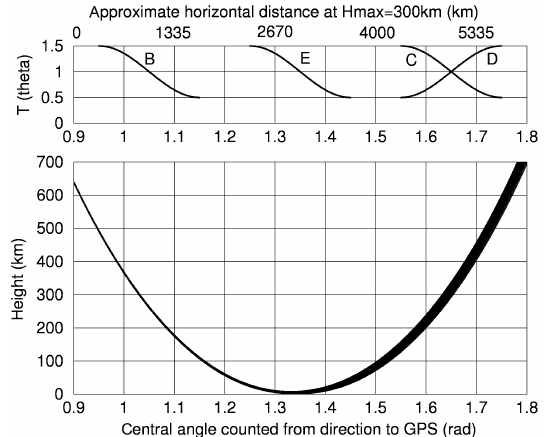
Figure A4. Lower panel: set of ray trajectories between GPS and LEO spanning the troposphere. Upper panel: functions modeling horizontal inhomogeneity of electron density in the